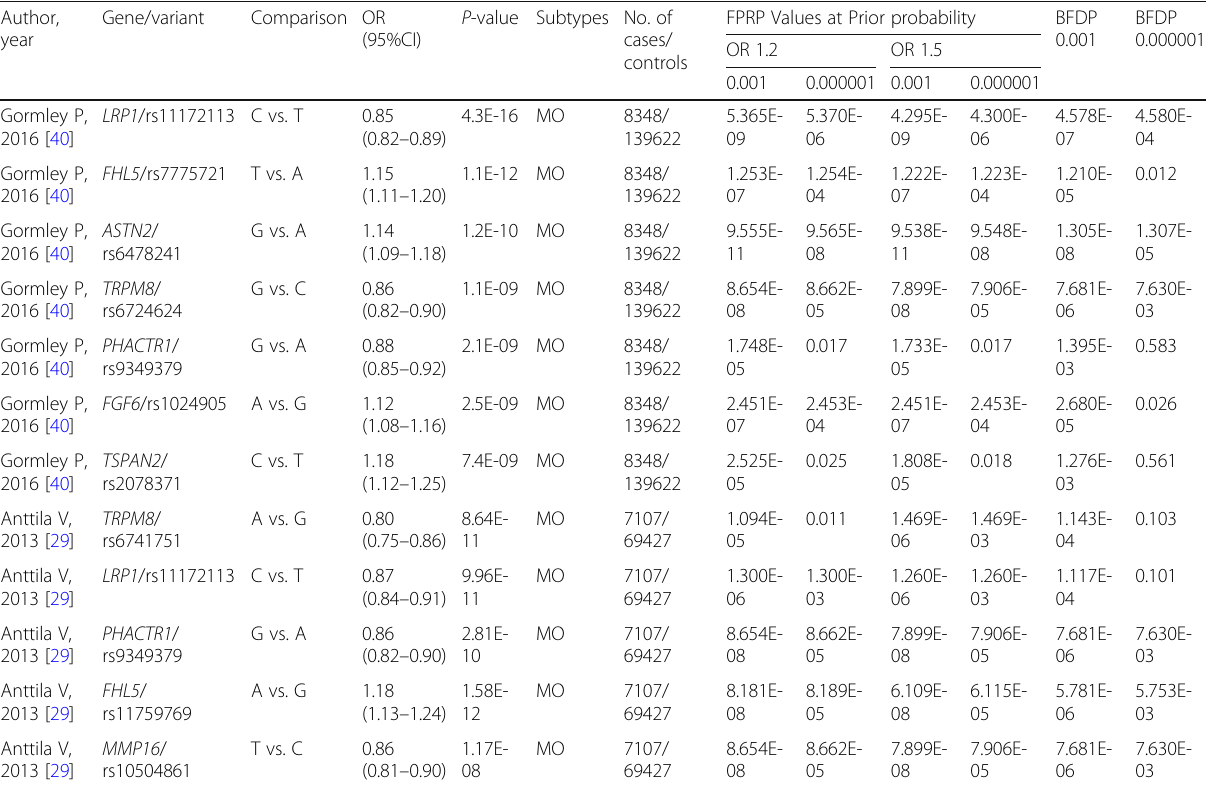
Table 5 Subgroup analysis results of genetic variants with statistically significance ( P -value< 5*10 − 8 ) from GWAS studies based